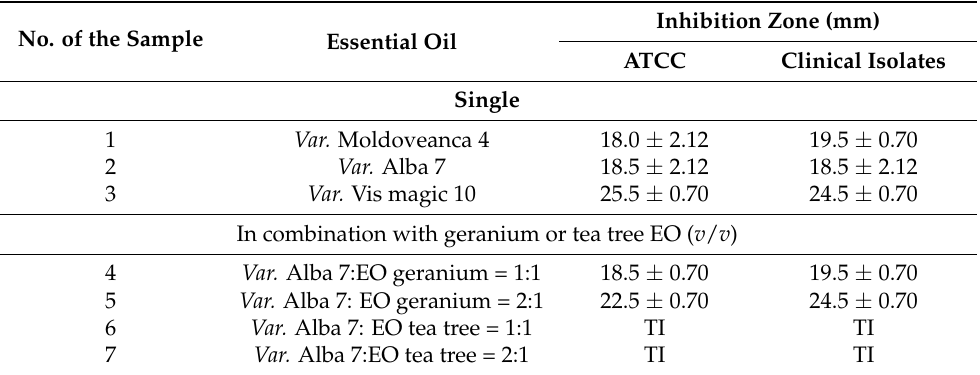
Table 5. Diameters of the inhibition zones of EOs against E. coli .